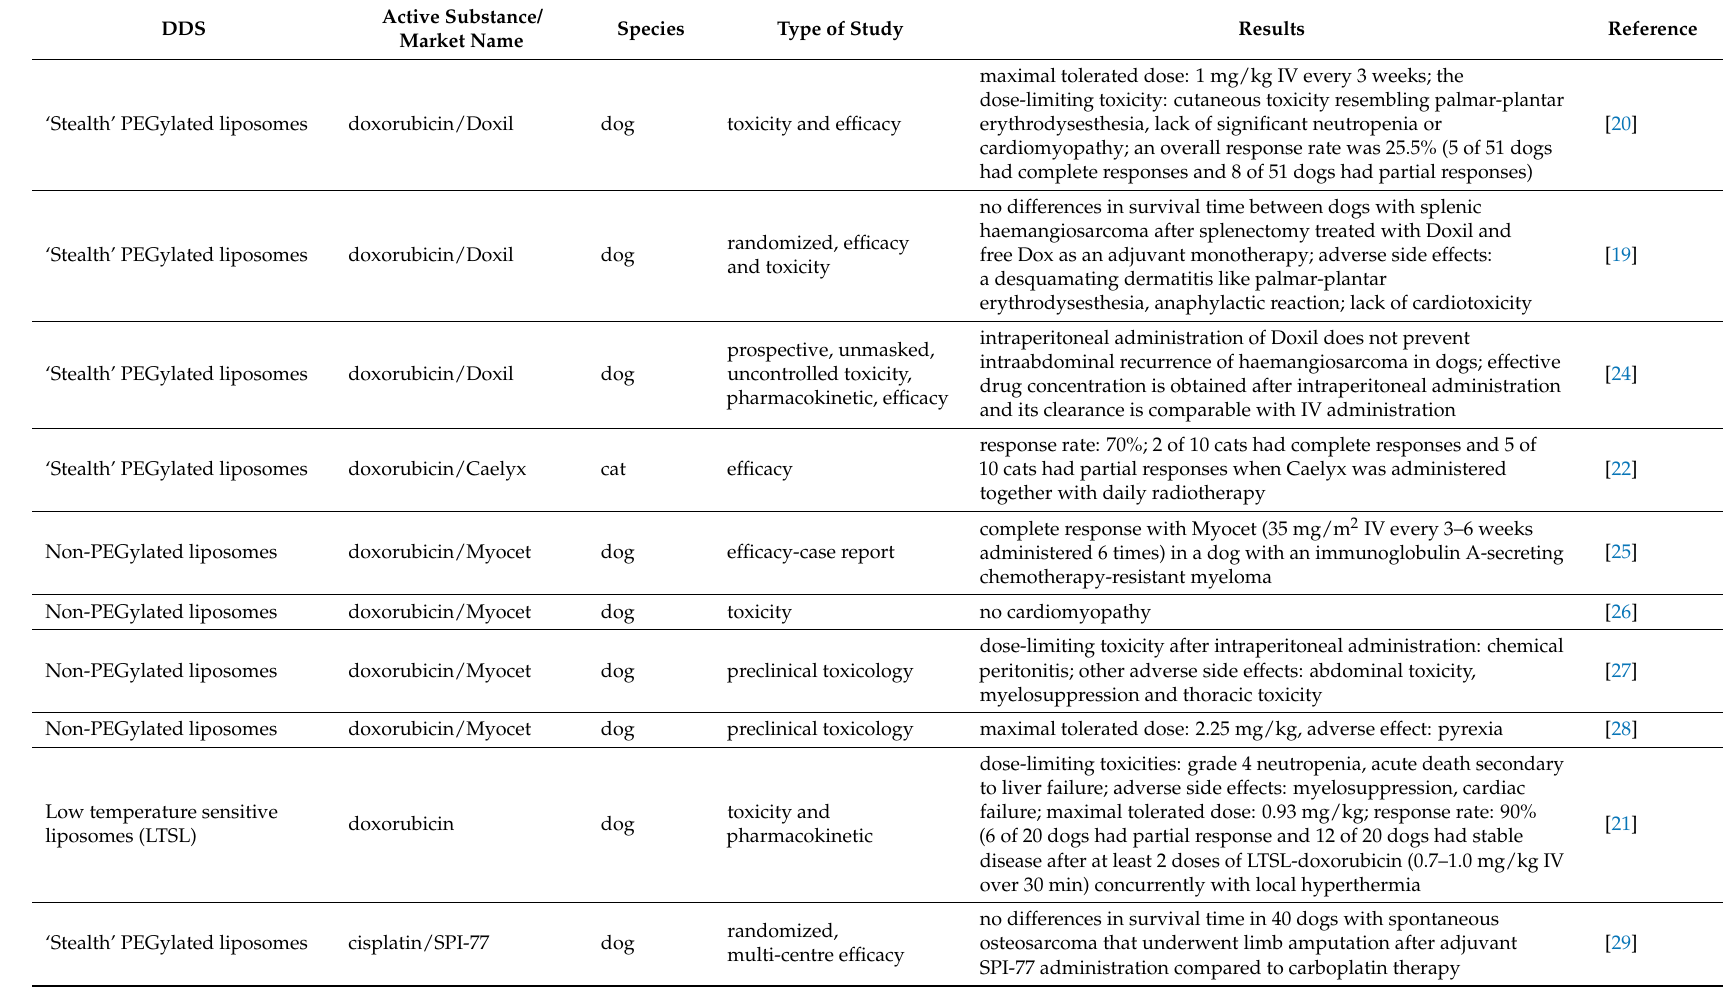
Table 1. Preclinical and clinical trials on the use of liposomes and nanoparticles as drug delivery systems (DDS) in dogs and